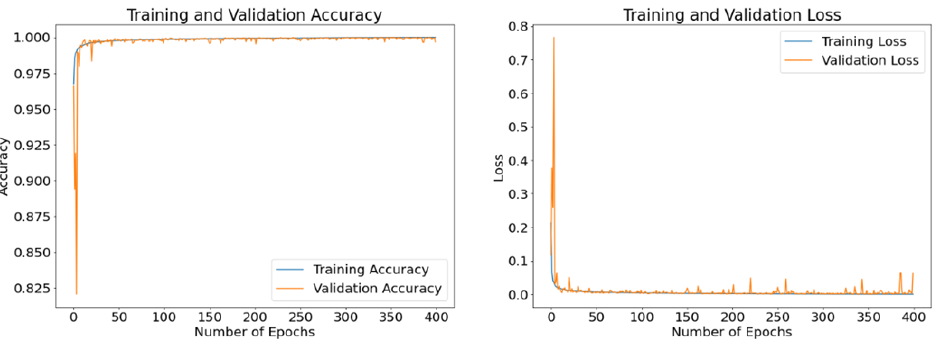
Figure 15. Accuracy and loss curves generated by RMSProp optimizer after model training (blue) and validation (orange) using a batch size of 8 samples and up to 400 epochs.